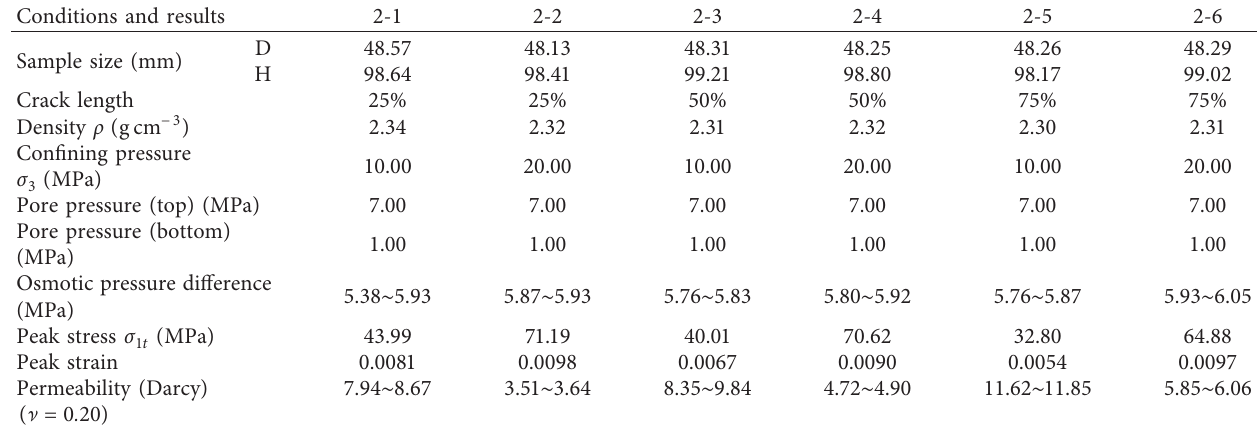
Table 3: Seepage tests results of single-cracked sandstone filled with cement